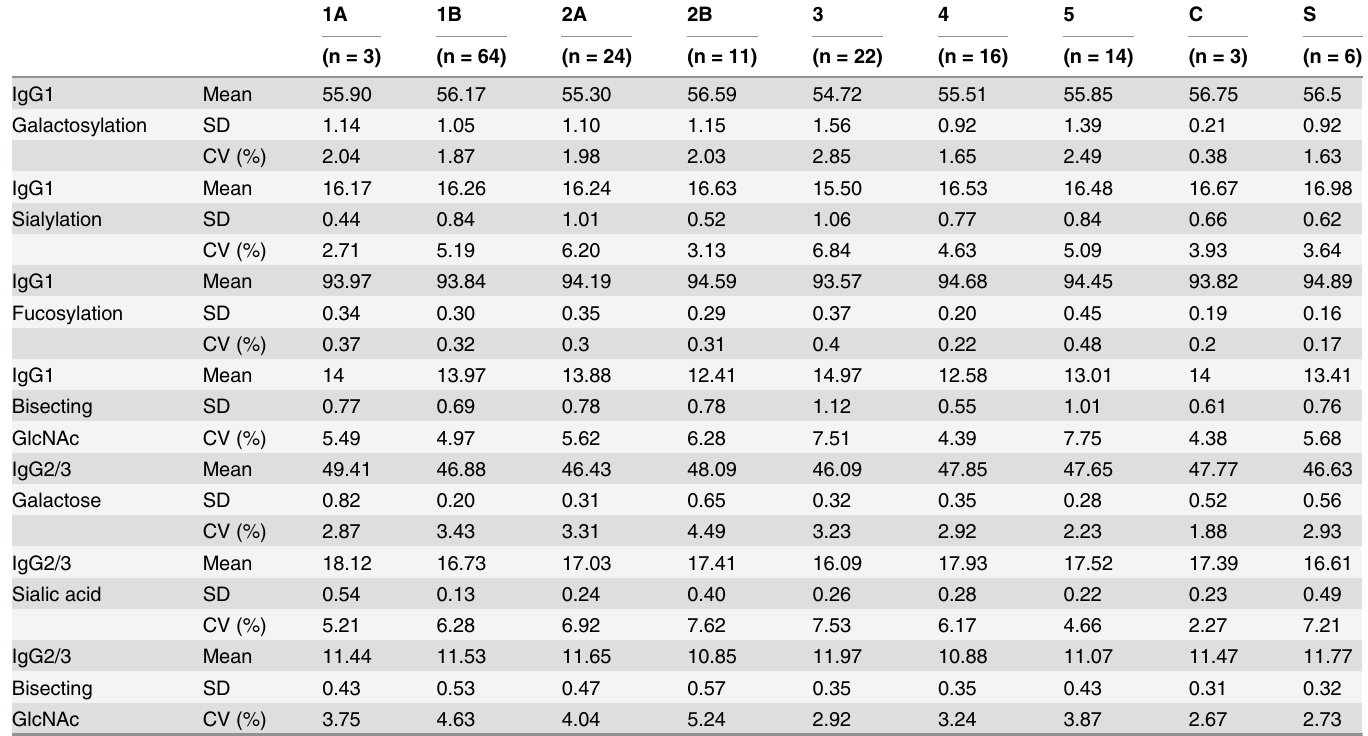
Table 1. Overview of the IgG Fc N -glycosylation of seven different IVIg